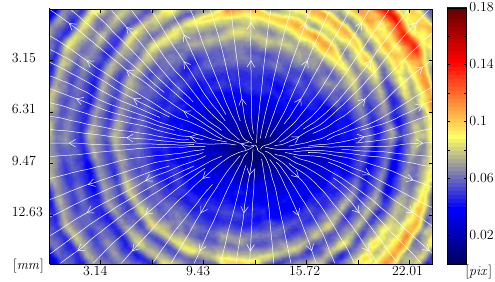
Figure 10: Color-shift estimation in pixels rooted from sub-pixel NCC measurements for the red to blue colorband of the mulit- rotor